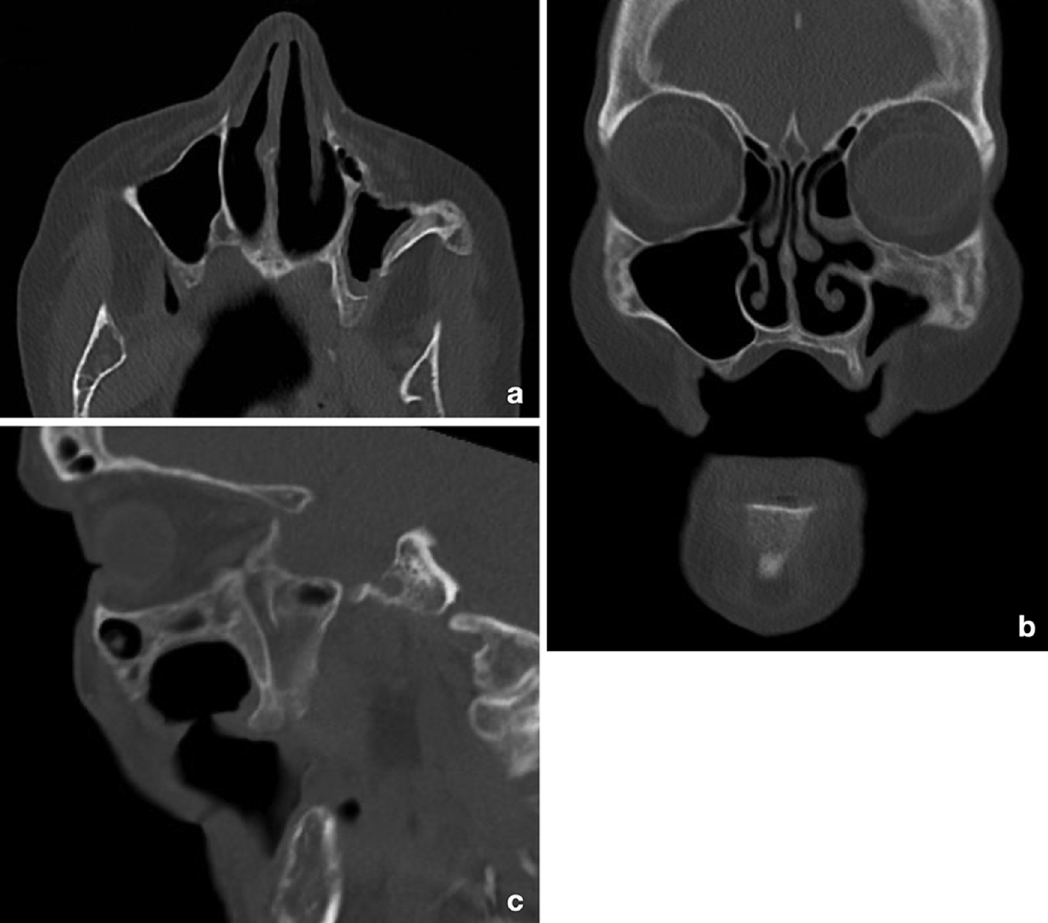
Fig. 2. Midface CT-Scan. Midface CT-scan showing a 22 (cid:1) 25 mm bone defect on the lateral wall of the left maxillary sinus, and stage II CMA with inward bowing of the medial wall and thickening of the lateral and superior walls. (a) Axial plane. (b) Coronal plane. (c) Sagittal